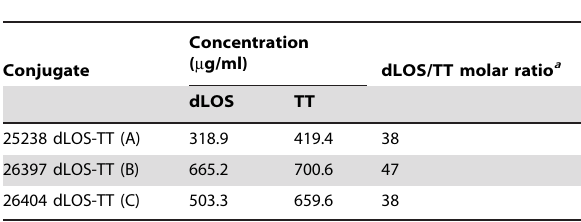
Table 1. Composition of conjugate